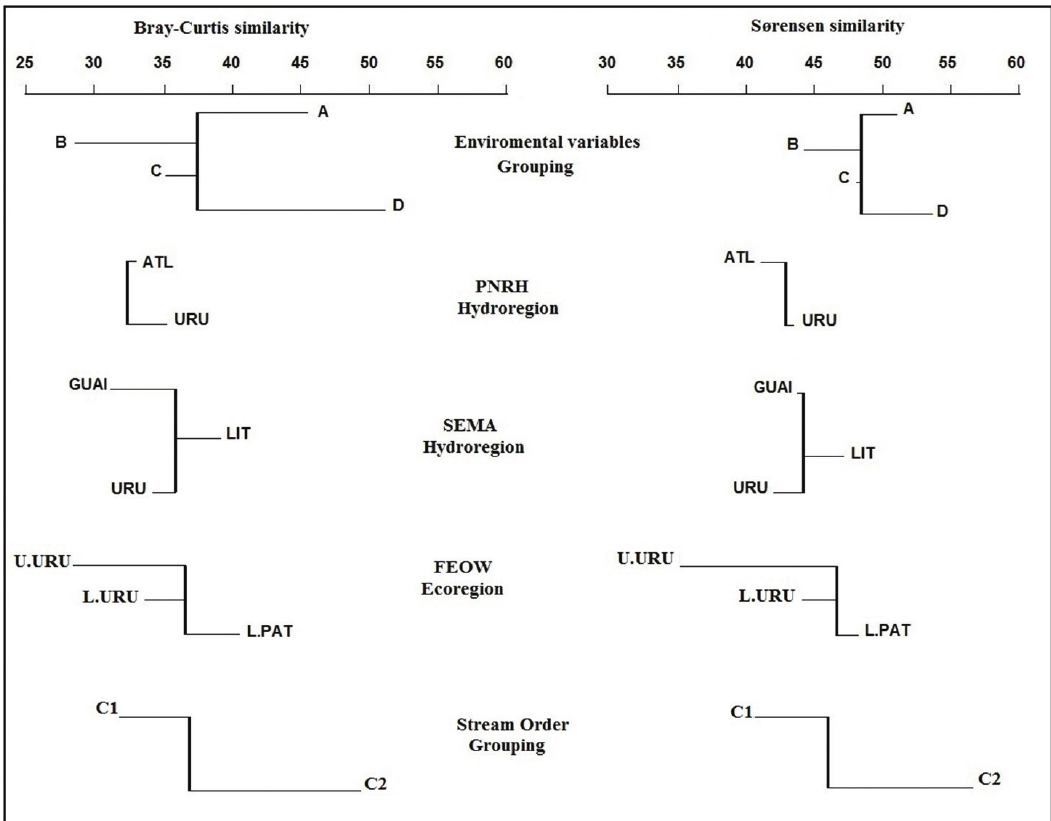
Figure 2. Mean similarity dendrogram to genus level. The arms (X axis) represent the mean similarity within the group ( W ), vertical lines (Y axis) represent the global mean similarity between groups ( B i GUAI = Guaíba; LIT = Littoral; U.URU = Upper Uruguay; L.URU = Lower Uruguay; L.PAT = Laguna dos Patos; C1 = 1ª to 3ª stream order e C2 = 4ª and 5ª stream